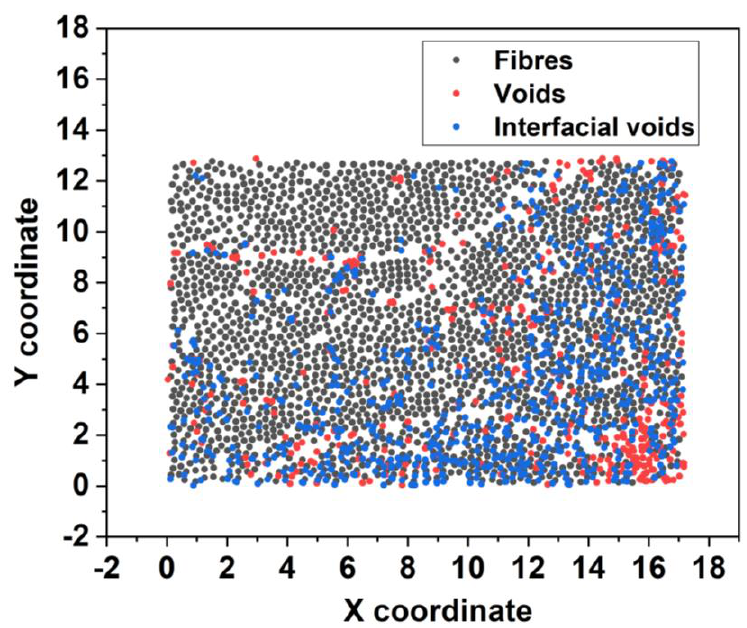
Figure 6. Bulk and interfacial voids detected by the algorithm.